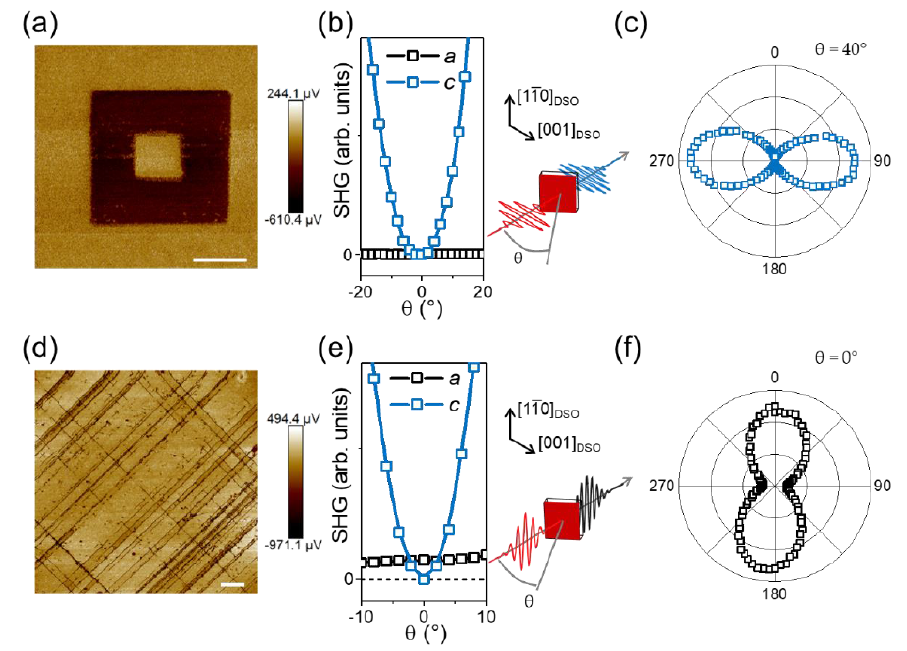
Figure 8. Optical detection of a -domains in PZT. ( a ) PFM scan of a single domain, c -oriented film. The scale bar is 1 µ m. ( b ) SHG tilt scan showing the increased contribution from c -domains with increased tilting angle. The scale bar is 2 µ m. ( c ) Polarizer measurement at a 40 ◦ tilt angle evidencing a single polar axis in the film. ( d – f ) Corresponding PFM, tilt scan and polarizer measurement at normal incidence for a mixed a -/ c -domain state,